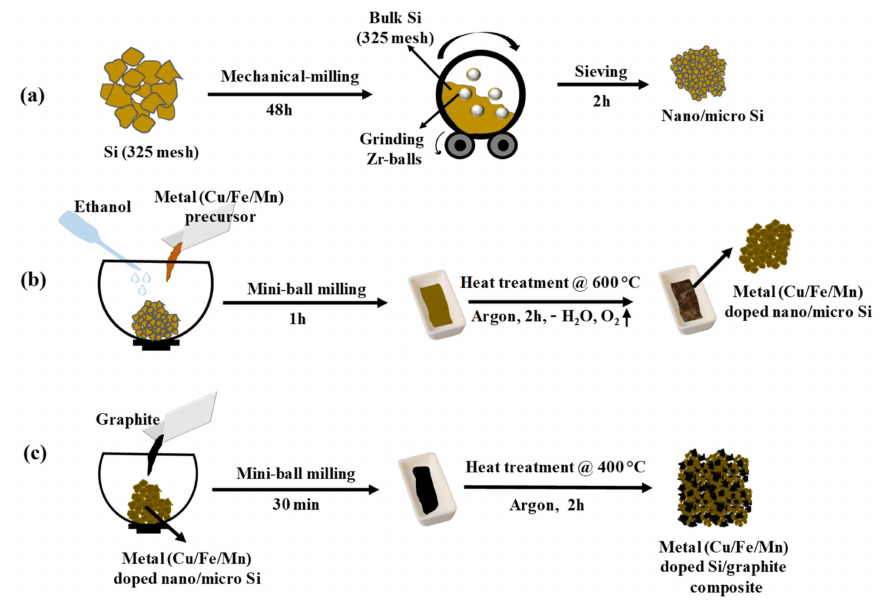
Figure 1. Schematic of step-by-step preparation of metal (Cu/Fe/Cu)-doped Si/graphite composite materials. ( a ) Preparation of nano/micro Si particles from bulk Si (325 mesh); ( b ) fabrication of metal doping into nano/micro Si particles; ( c ) metal (Cu/Fe/Mn)-doped Si/graphite composite